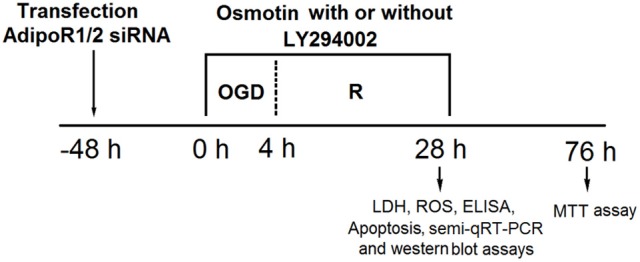
The time axis of OGD/R exposure and osmotin administration with or without LY294002 treatment. OGD/R, oxygen and glucose deprivation/reperfusion; AdipoR, adiponectin receptor; siRNA, small interfering RNA; semi-qRT-PCR, Semi-quantitative real-time reverse transcriptase polymerase chain reaction; LDH, lactate dehydrogenase; ROS, reactive oxidative stress; MTT, 3-(4, 5-dimethylthiazol-yl)-2, 5-diphenyl-2-H-tetrazolium bromide.